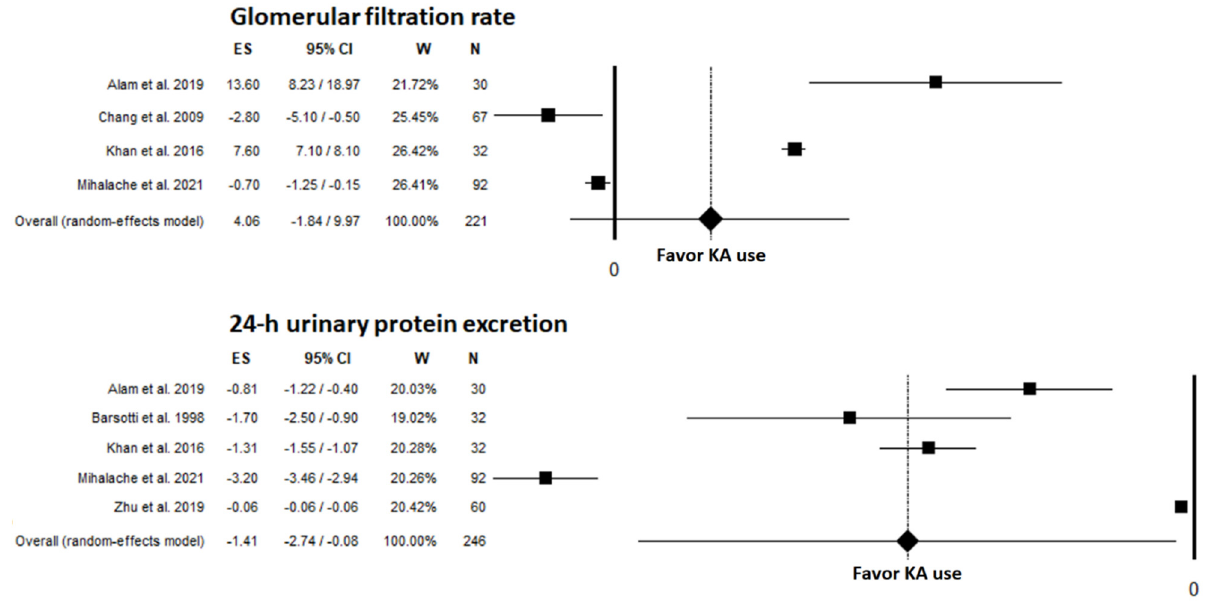
Figure 2. Meta-analyses for renal outcomes reported in studies included in the systematic review; GFR [8,12,23,27], 24-h upe [8,23,25,27,30]. KA,